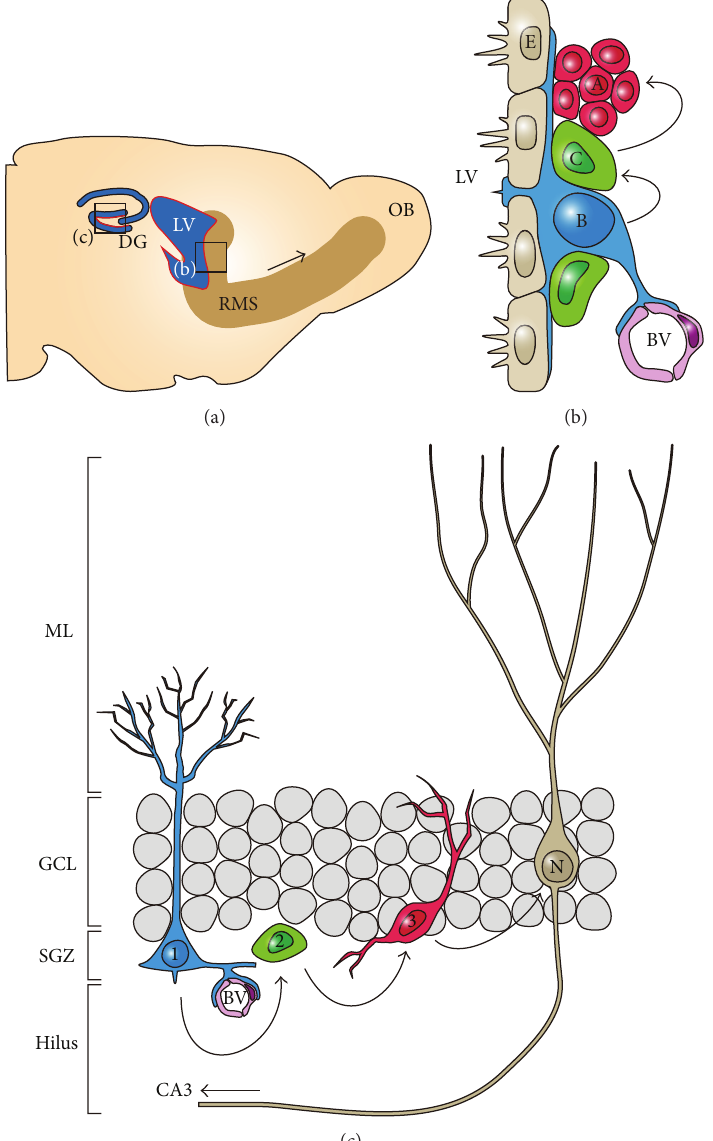
Figure 3: Adult neurogenesis in the rodent brain. (a) A sagittal view of the adult rodent brain. Red areas in the LV and DG indicate the SVZ and the SGZ, respectively, where active adult neurogenesis occurs. Arrow shows the direction of RMS through which immature neuroblasts born in the SVZ migrate to the OB. (b) A schematic image of adult neurogenic niche and sequential progression of adult neurogenesis in the SVZ. E: ependymal cell, A: type A cell, B: type B cell, C: type C cell, and BV: blood vessel. (c) A schematic image of adult neurogenic niche and sequential progression of adult neurogenesis in the SGZ. 1: type 1 cell, 2: type 2 cell, 3: type 3 cell, and N: mature